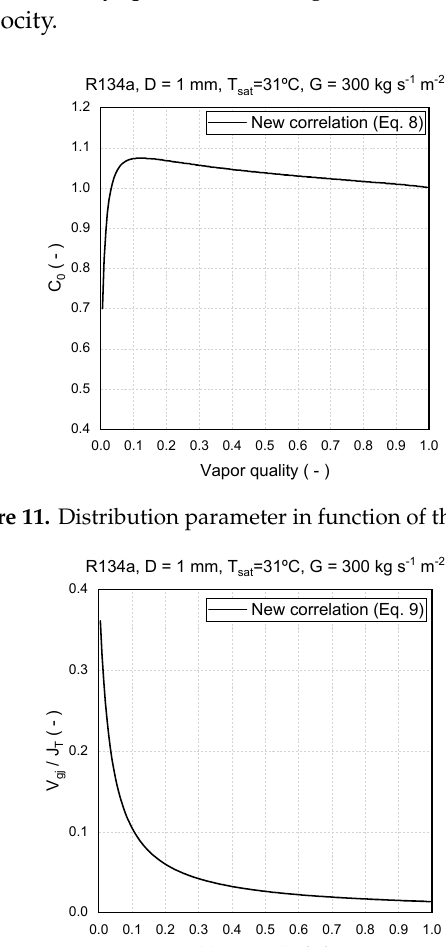
Figure 12. Ratio between the drift velocity and the mixture velocity in function of the quality.